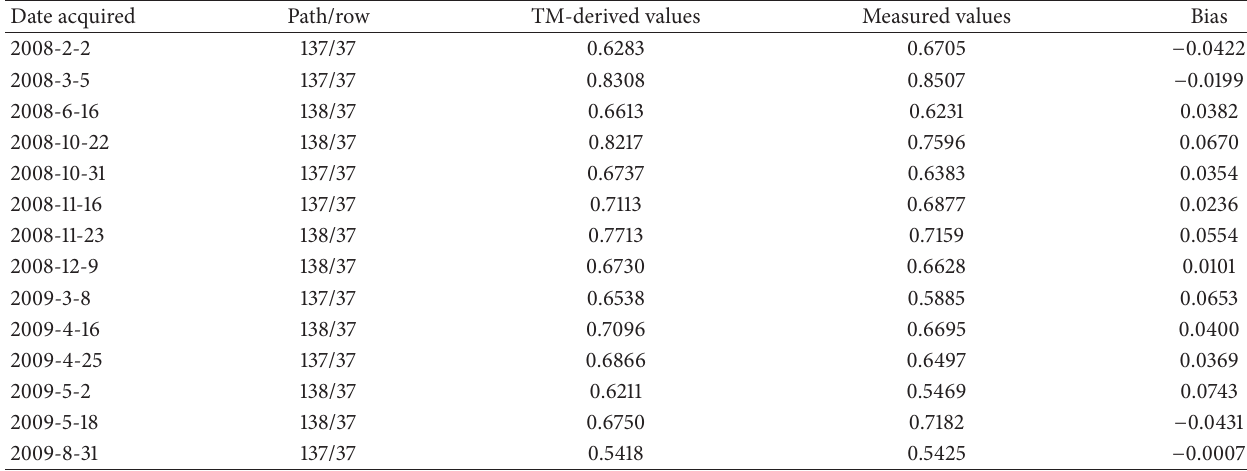
Table 1: The difference between TM-derived albedo and AWS-measured